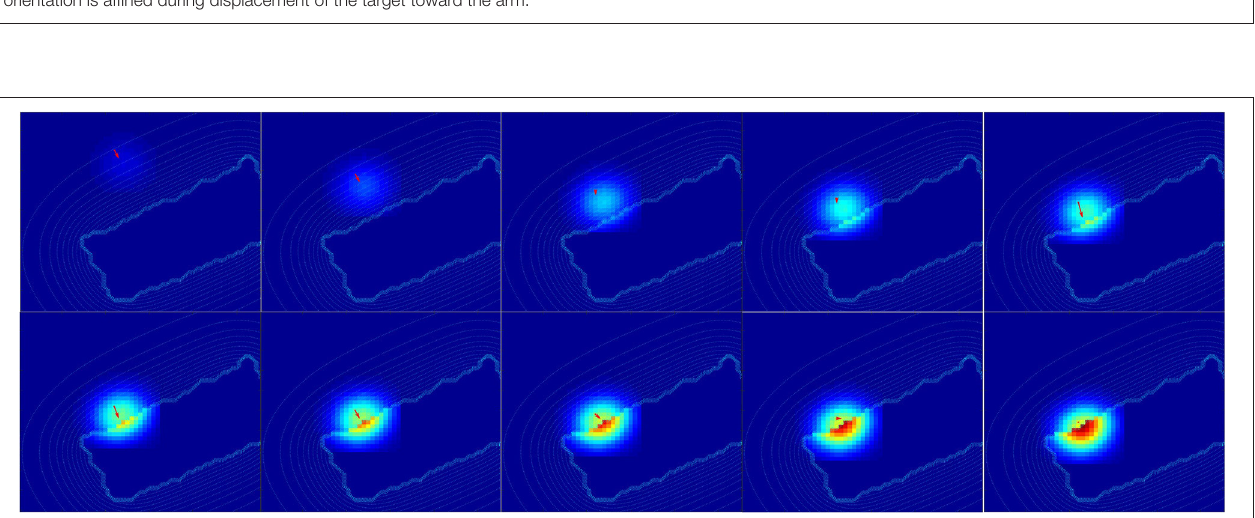
Frontiers in Neurorobotics | www.frontiersin.org